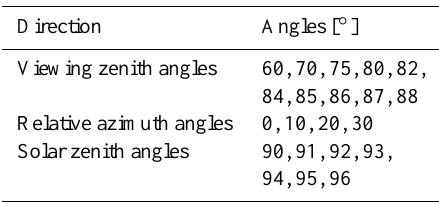
Table 2. Viewing and solar directions used for aerosol retrievals.